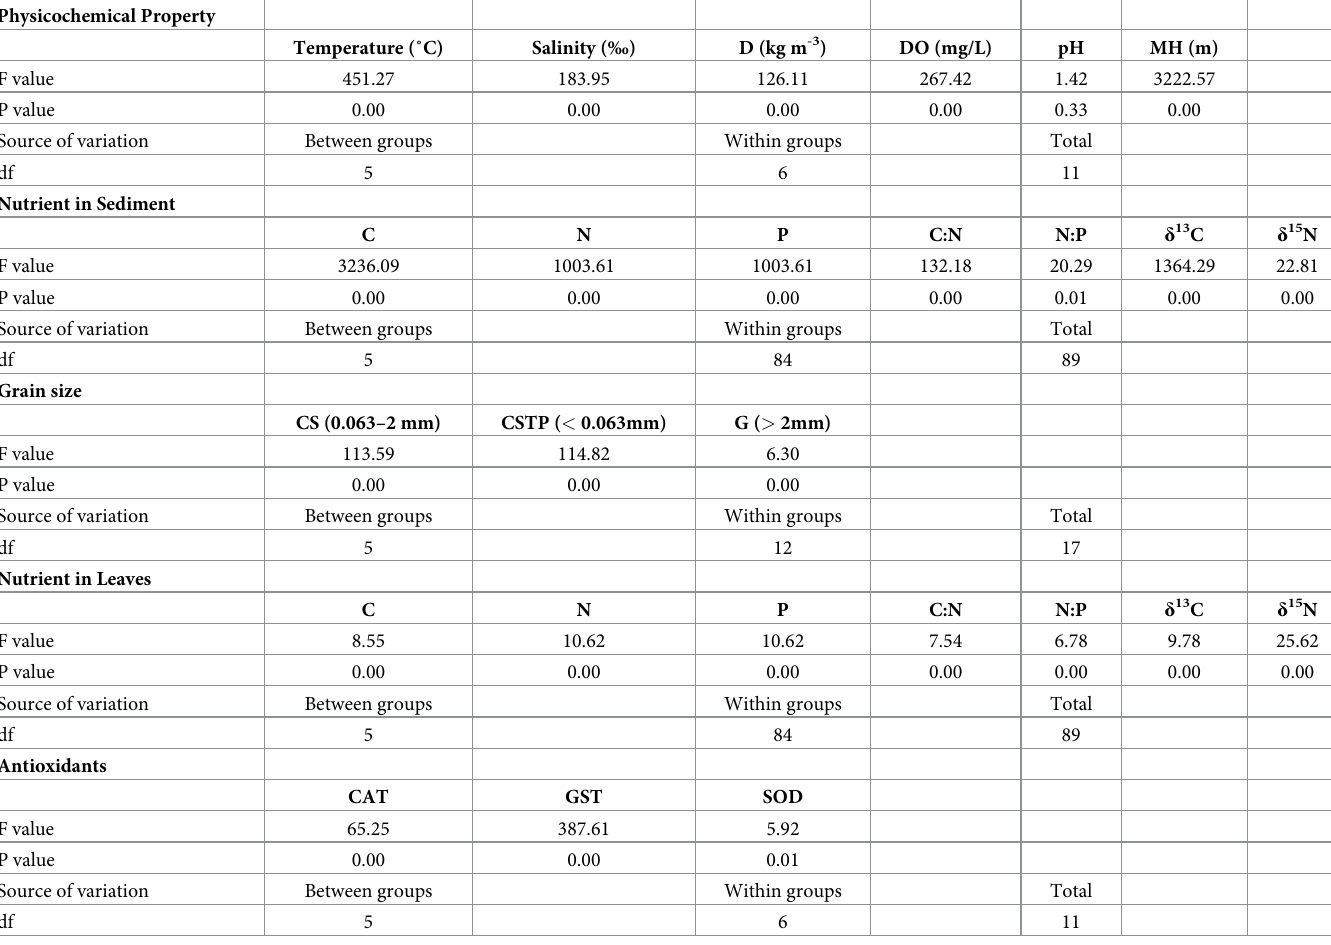
Table 3. F values and corresponding significance level (p values) after ANOVA test for physicochemical parameters, nutrients and antioxidants. Physicochemical